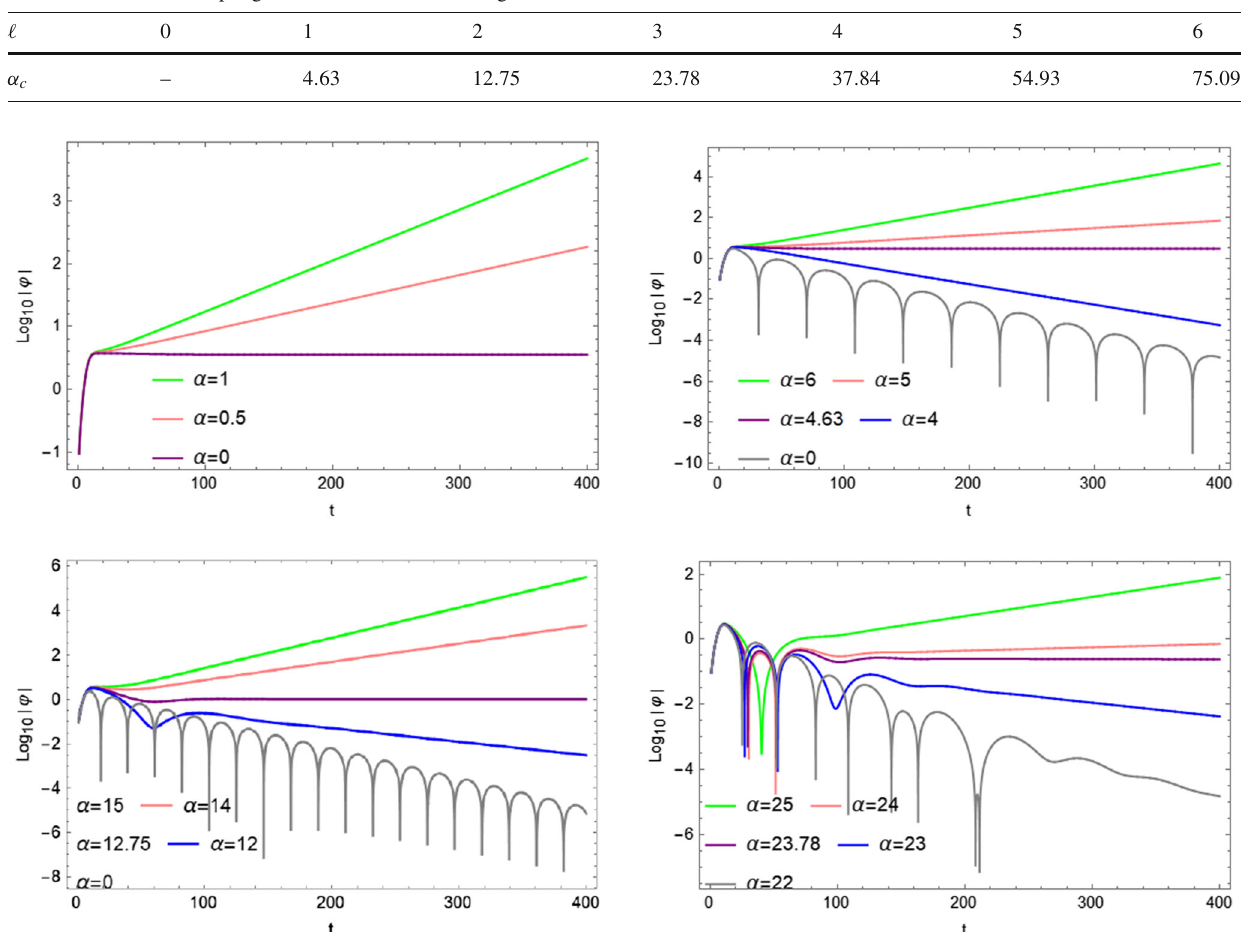
Fig. 1 The fundamental QNM frequency as a function of the GB coupling for different (cid:4) modes Table 1 The critical coupling for different momentum angular